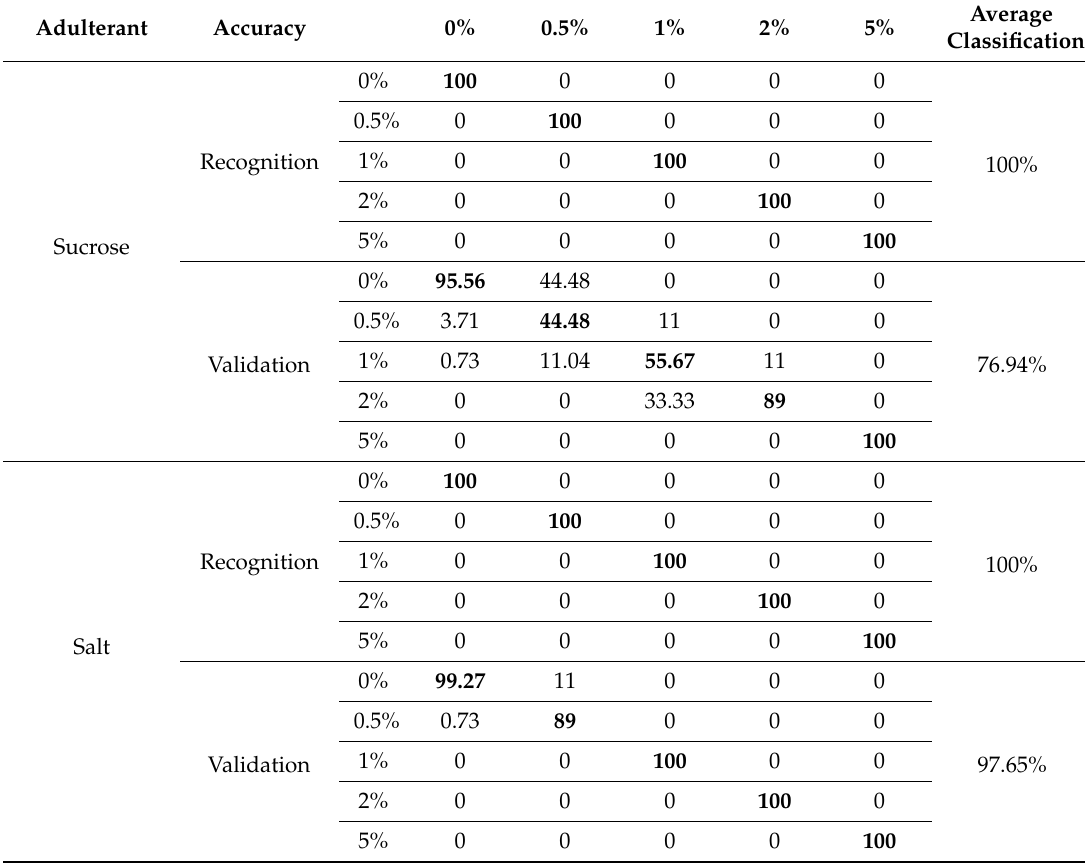
Table 6. LDA classification after three-fold cross-validation and SG and MSC pretreated NIRS spectra when the adulterant concentration was used as class variable on sucrose and salt dataset.